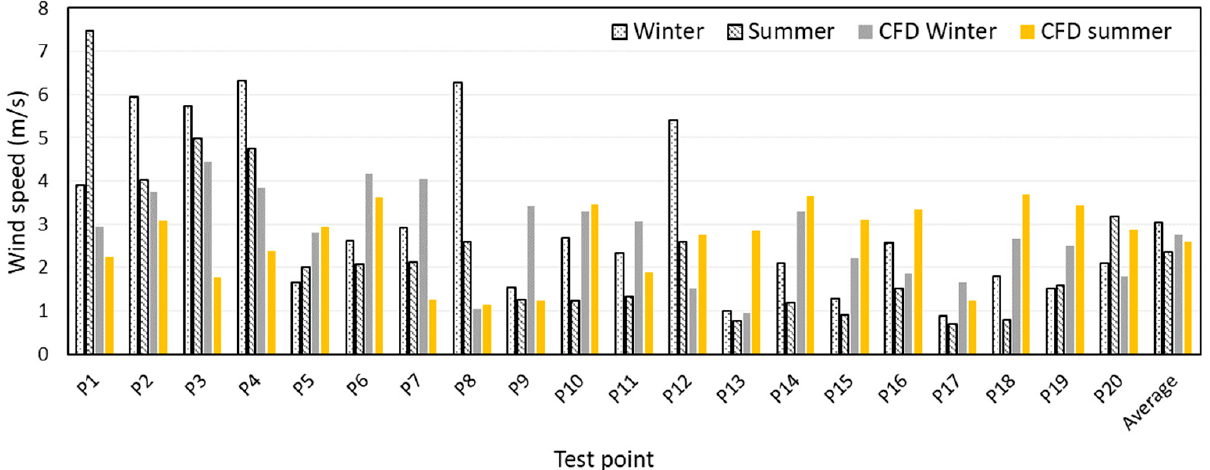
Figure 14. Wind speed comparison of the wind tunnel measurement and the CFD simulation.